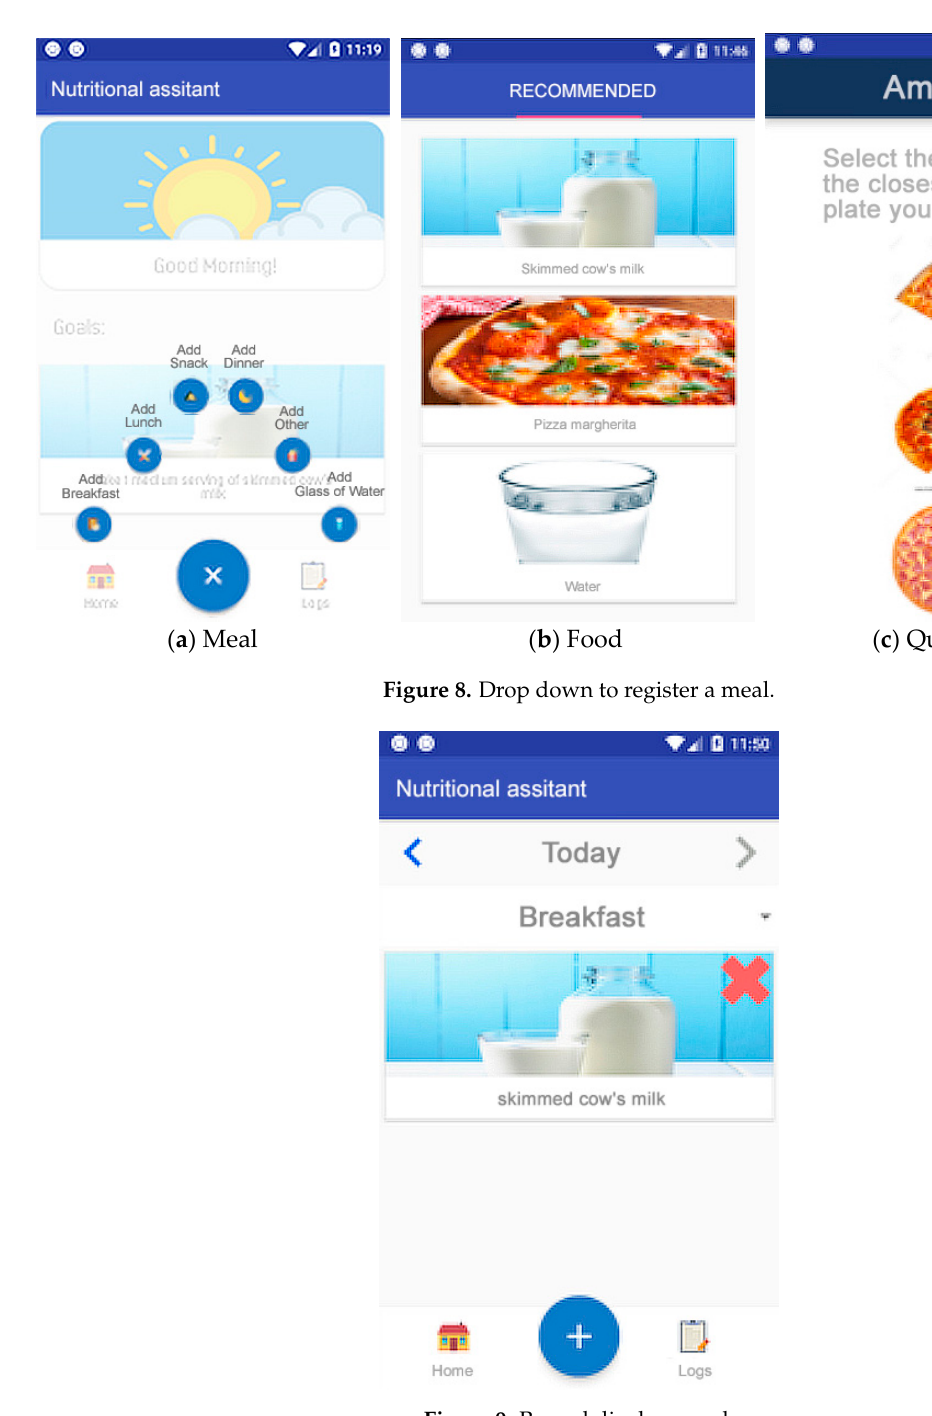
15 of 21 Figure 7. Welcome screen and display of outstanding goals.